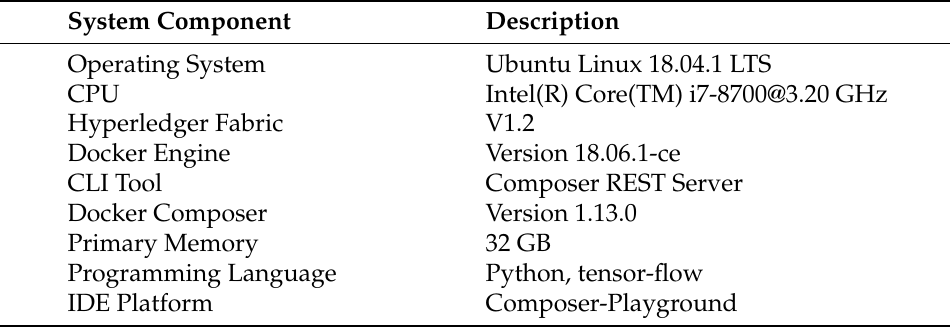
Table 2. Proposed system tools and techniques of